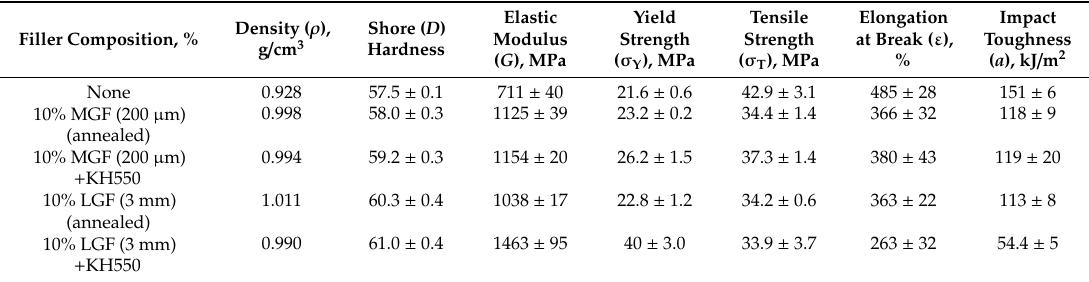
Table 3. Mechanical properties of GUR 2122 and GUR 2122-based composites.